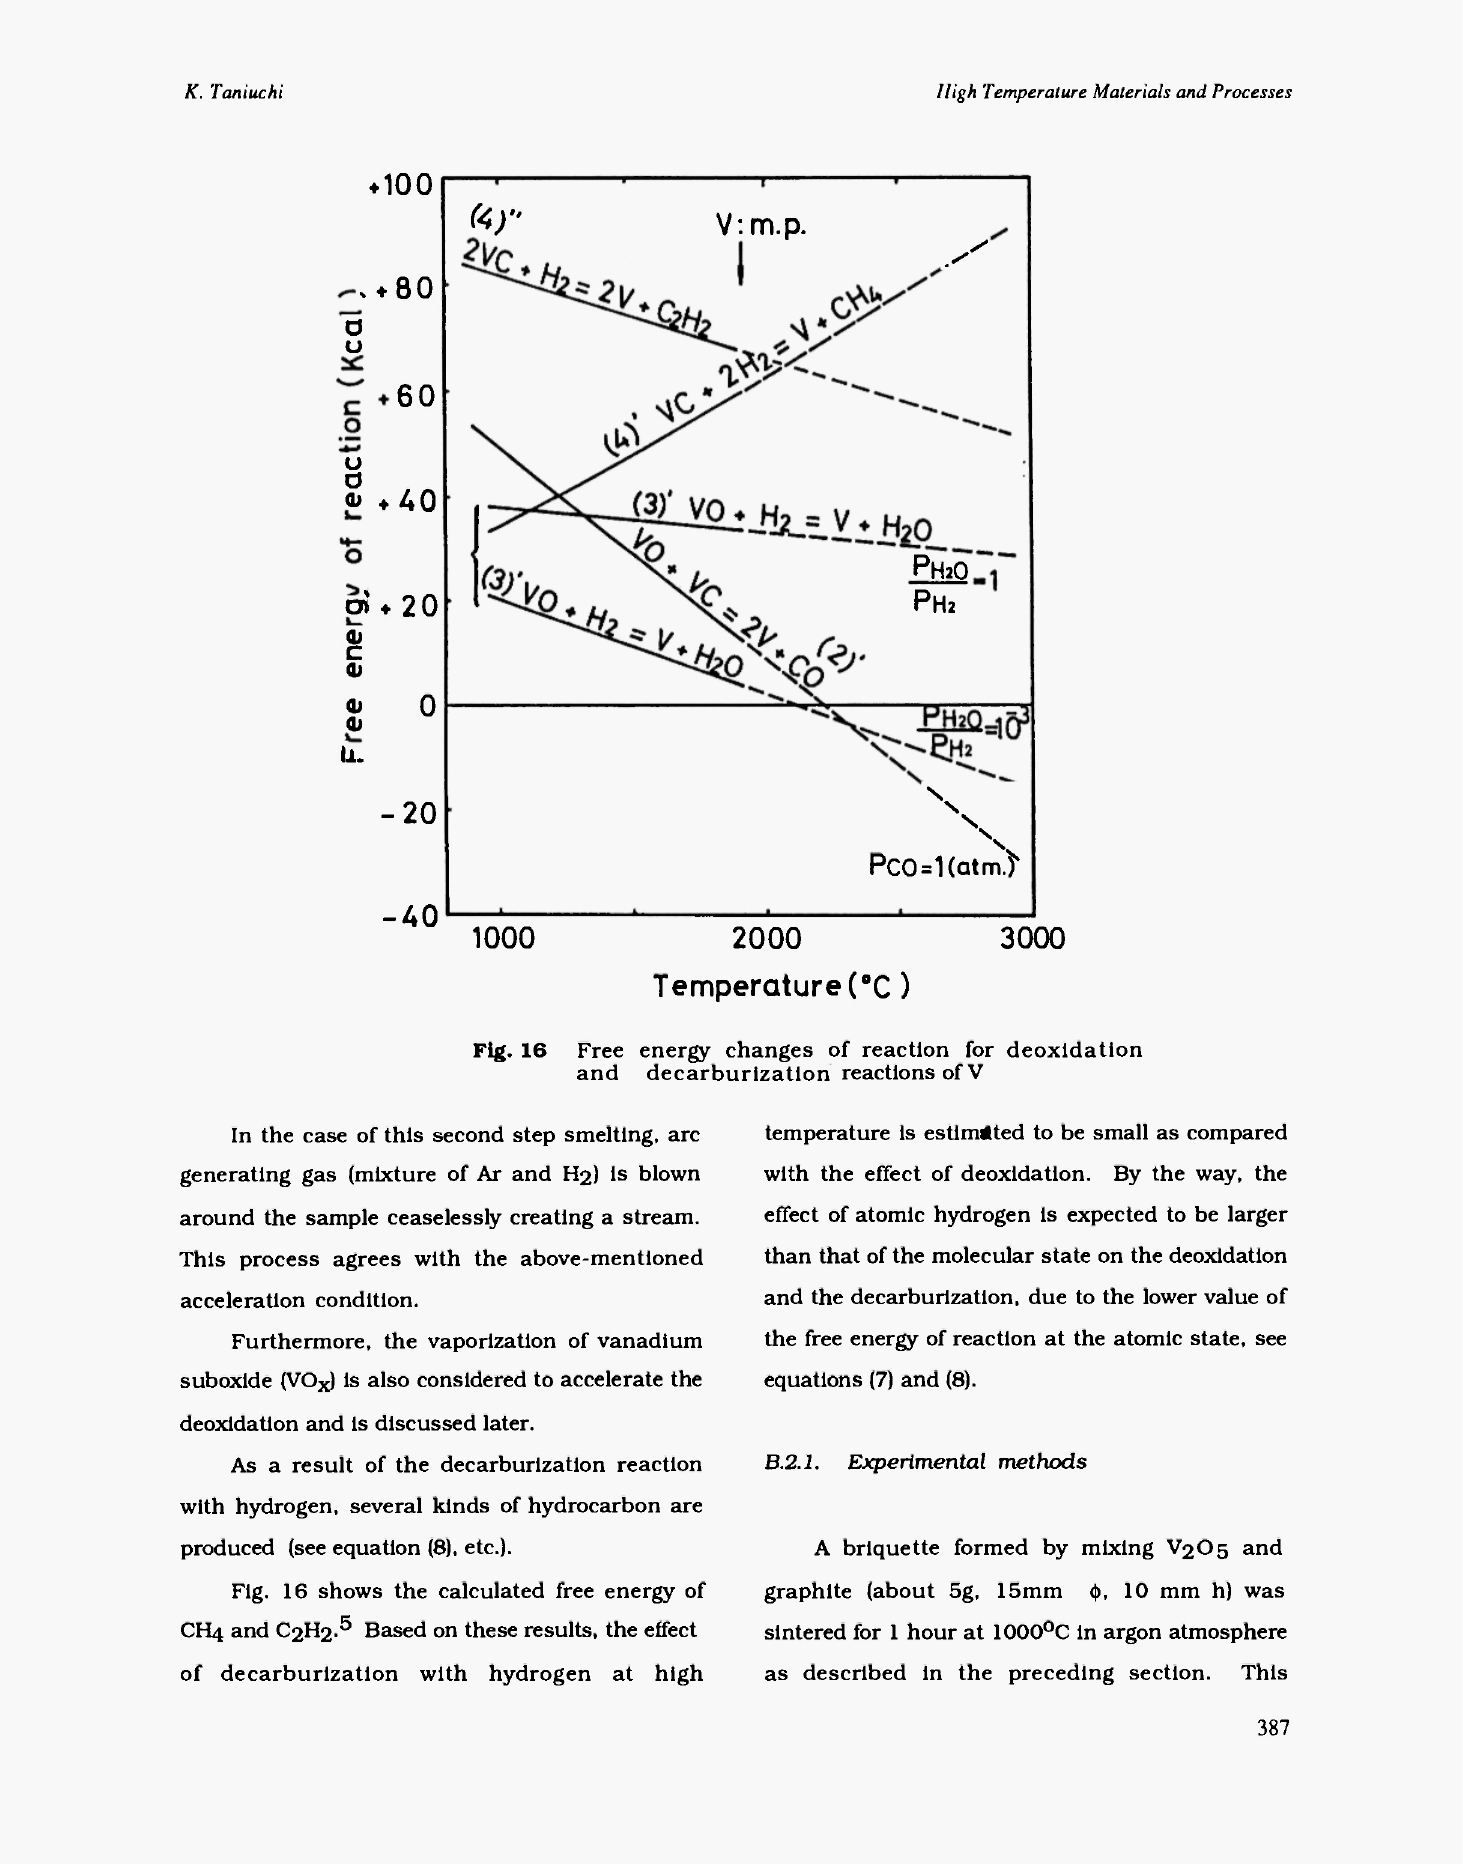
Fig. 16 Free energy changes of reaction for deoxidation and decarburization reactions of